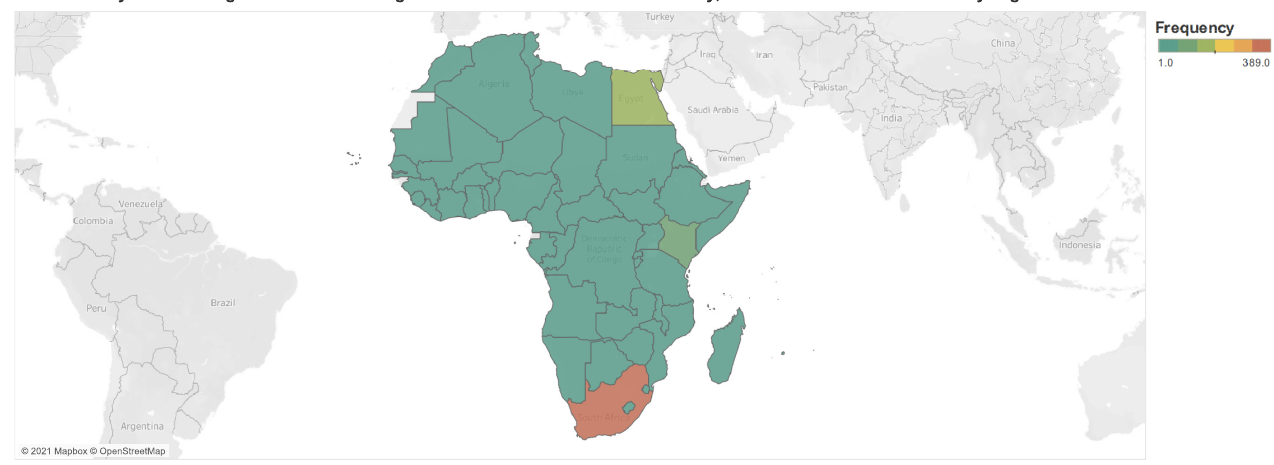
Fig 4. Respondents’ preferred destination for neurosurgical